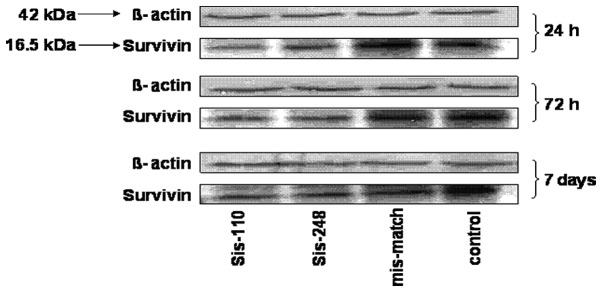
Western blot analysis indicates reduced survivin expression following siRNA treatment in FTC-133 cells.